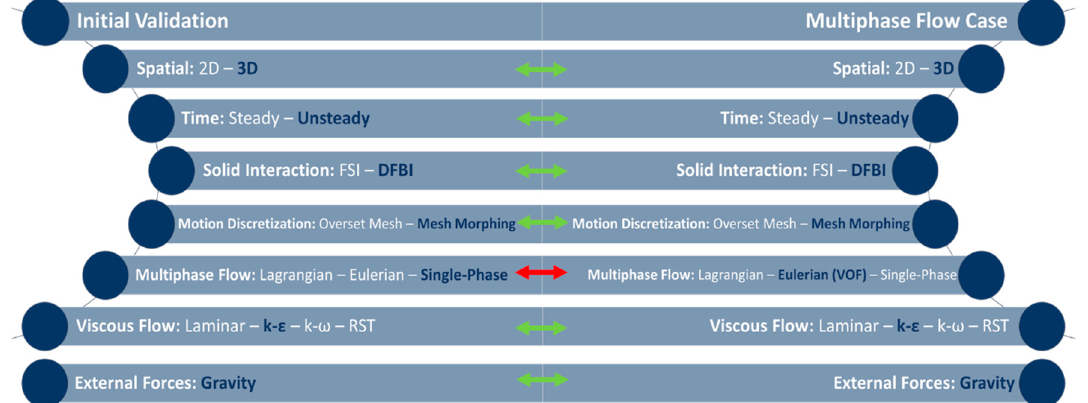
Figure 8. Comparison of the models used for the two analyses conducted.